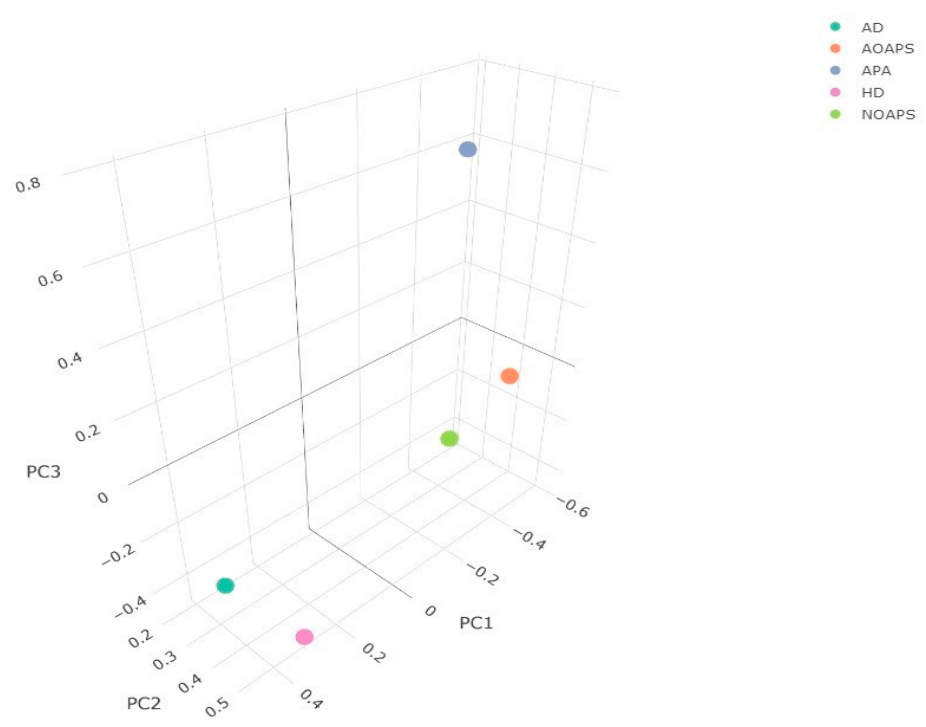
Figure 3. Three-dimensional principal component scatterplot. Each color dot represents a trait analyzed as denoted in the figure legend in the top-right corner. Each axis is labeled with the principal component they